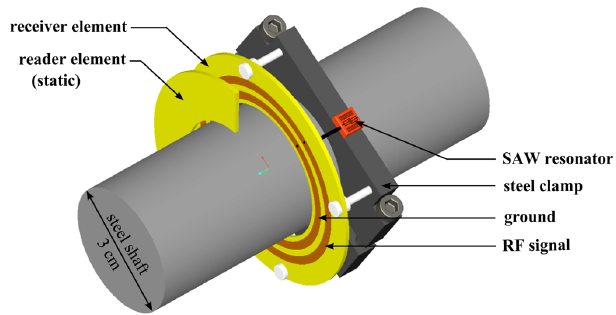
Figure 3. 3-D model of a capacitive coupler based on coplanar strip lines, placed around a 3cm diameter shaft and connected to a SAW resonator.